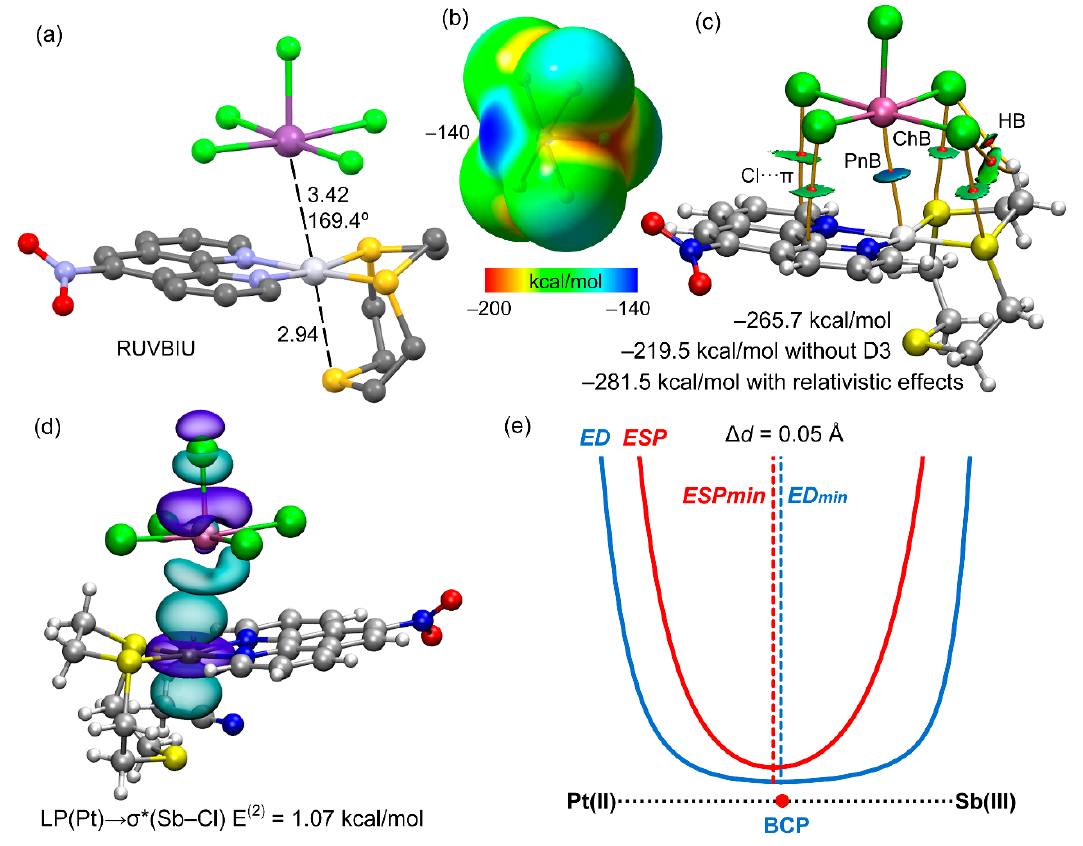
Figure 6. ( a ) X-ray structure of RUVBIU. Distances in Å . H-atoms omitted. Color code: Carbon grey, chlorine green, platinum light grey, antimony violet, sulfur yellow, oxygen red, nitrogen blue, iodine purple. ( b ) MEP surface of the [SbCl 5 ] 2 – unit. ( c ) QTAIM (bond CPs in red and bond paths as orange lines) and RDG isosurfaces of the salt. ( d ) NBO representation of the LP(Pt) → σ*(Sb– Cl) interaction. ( e ) ED/ESP profile along the Pt(II)···Sb(III) bond path in RUVBIU.